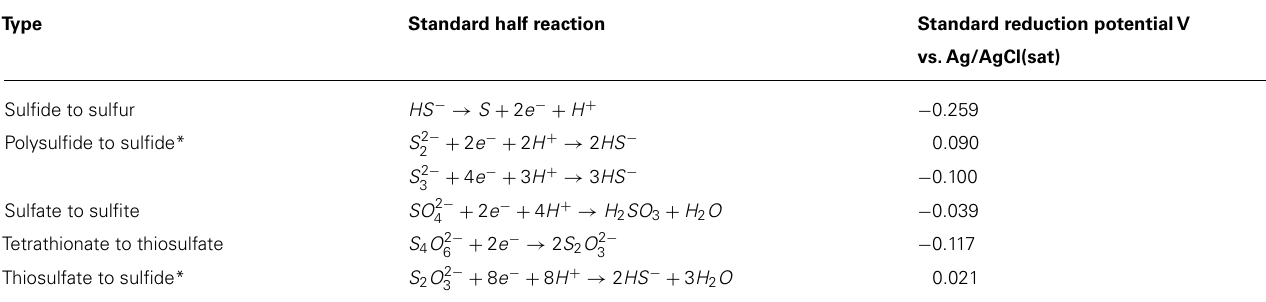
Table 2 | Selected reduction reactions of relevant sulfur compounds (taken from Bard etal., 1985).